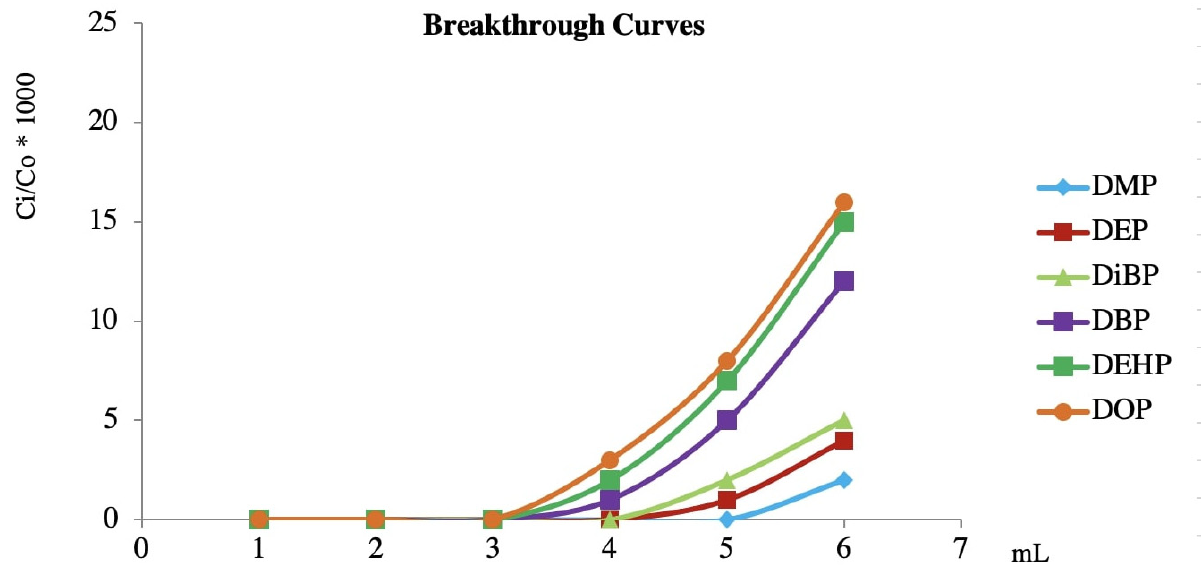
Figure 3. Adsorption isotherm curves at 25 °C of PAEs between the C 18 adsorbent and working solution.